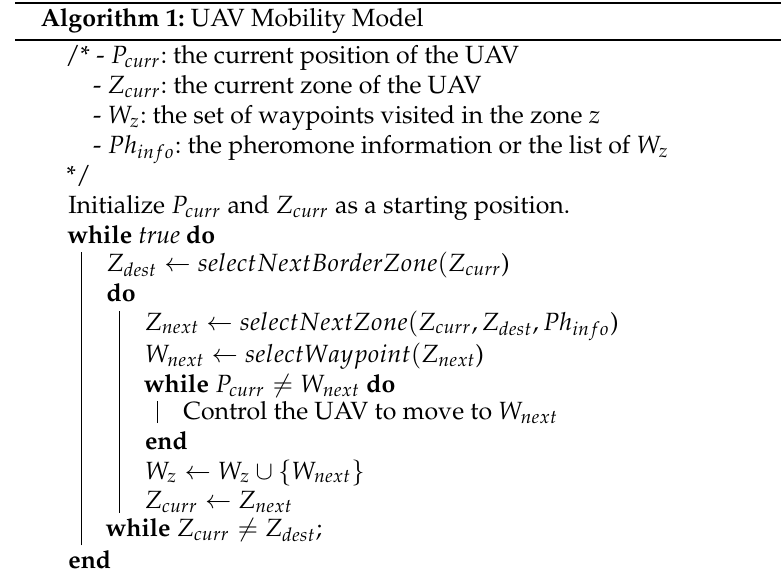
Algorithm 1: UAV Mobility